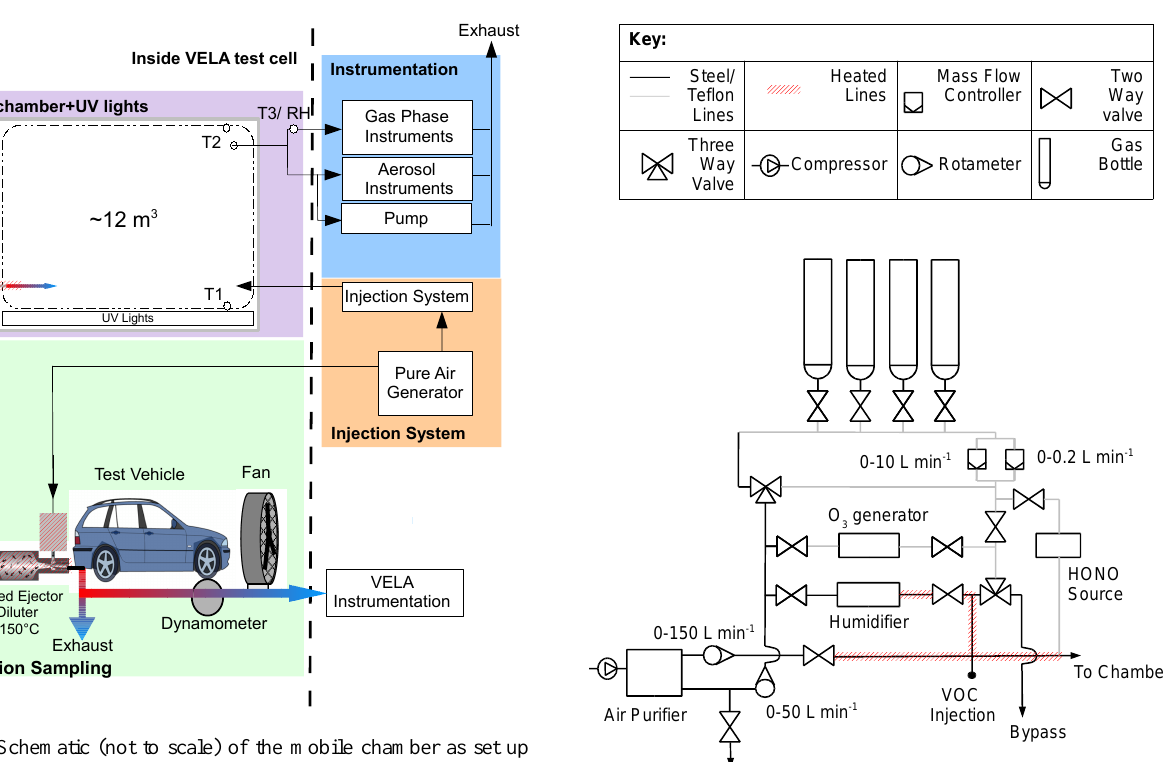
Fig. 1. Schematic (not to scale) of the mobile chamber as set up during experiments on a Euro 5 gasoline light-duty vehicle at the vehicle emissions laboratory (VELA) of the European Commission Joint Research Centre (JRC), Ispra, Italy. Highlighted are different sections of the set-up. Green: emissions sampling is performed us- ing a modified Dekati ejector equipped with a pressurized air heater. Purple: the smog chamber, an approximately 12.5m 3 (when full), nominally 9m 3 (2.5m × 1.8m × 1.9 m, L × W × H), 125 µm thick collapsible Teflon bag (suspended from a mobile aluminium frame (2.3m × 2m × 2.5m, L × W × H) with a battery of 40 100W UV lights. Orange: injection system and pure air generator. Blue: in- strumentation, which was located outside of the test cell. Gas phase instruments are connected to the chamber via Teflon tubing, while steel or copper tubing is used to connect aerosol instruments.